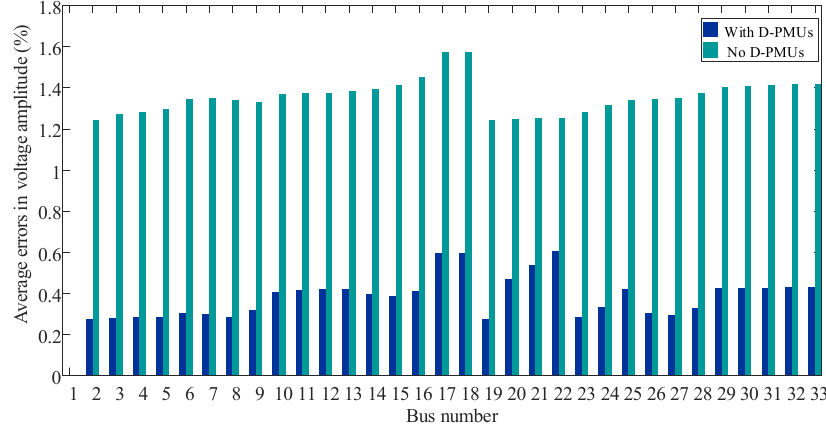
Figure 7. Comparison of average errors in voltage phase angle.